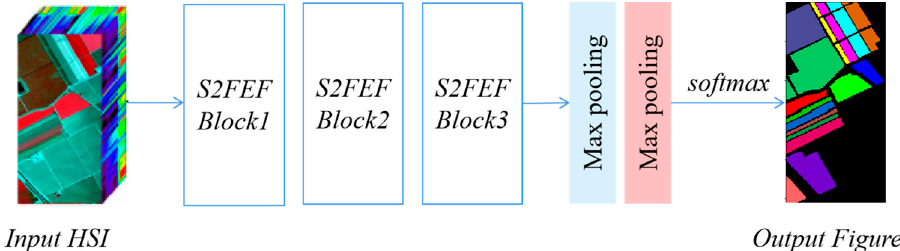
Figure 5. Architecture of the S2FEF-CNN. The two pooling layers are used in the spectral and spatial dimensions, respectively.